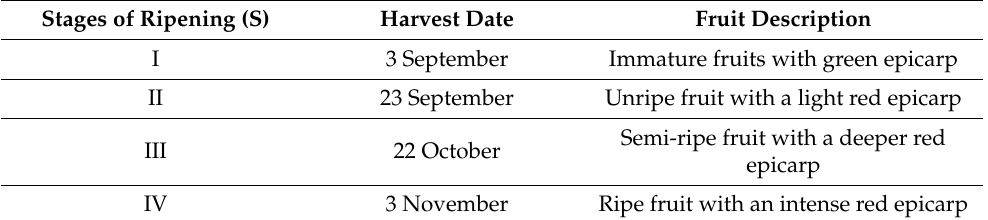
Table 1. Description of four different stages of coloring of pomegranate fruits. Stages of Ripening (S) Harvest Date Fruit Description I 3 September Immature fruits with green epicarp II 23 September Unripe fruit with a light red epicarp Semi-ripe fruit with a deeper red III 22 October epicarp IV 3 November Ripe fruit with an intense red